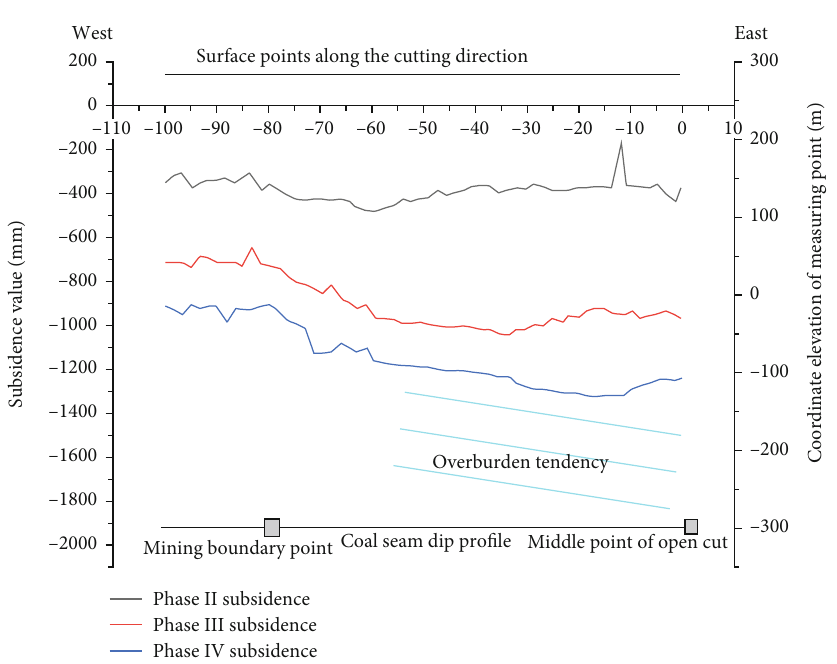
Figure 17: The subsidence with 3# lateral line in the dam.